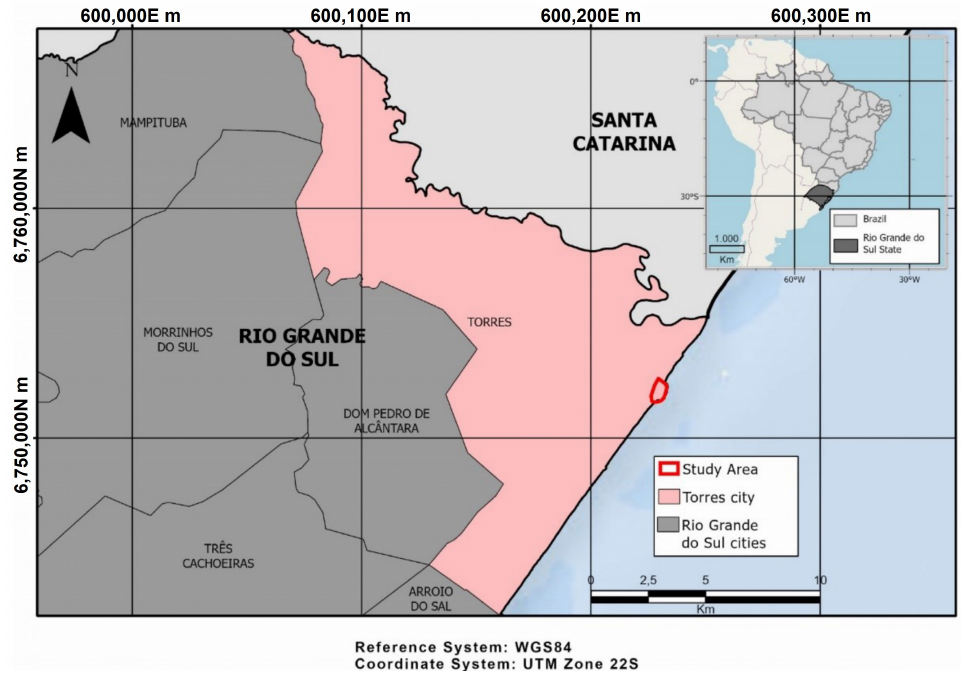
Figure 1. Localization map showing the location of the study area in Torres,